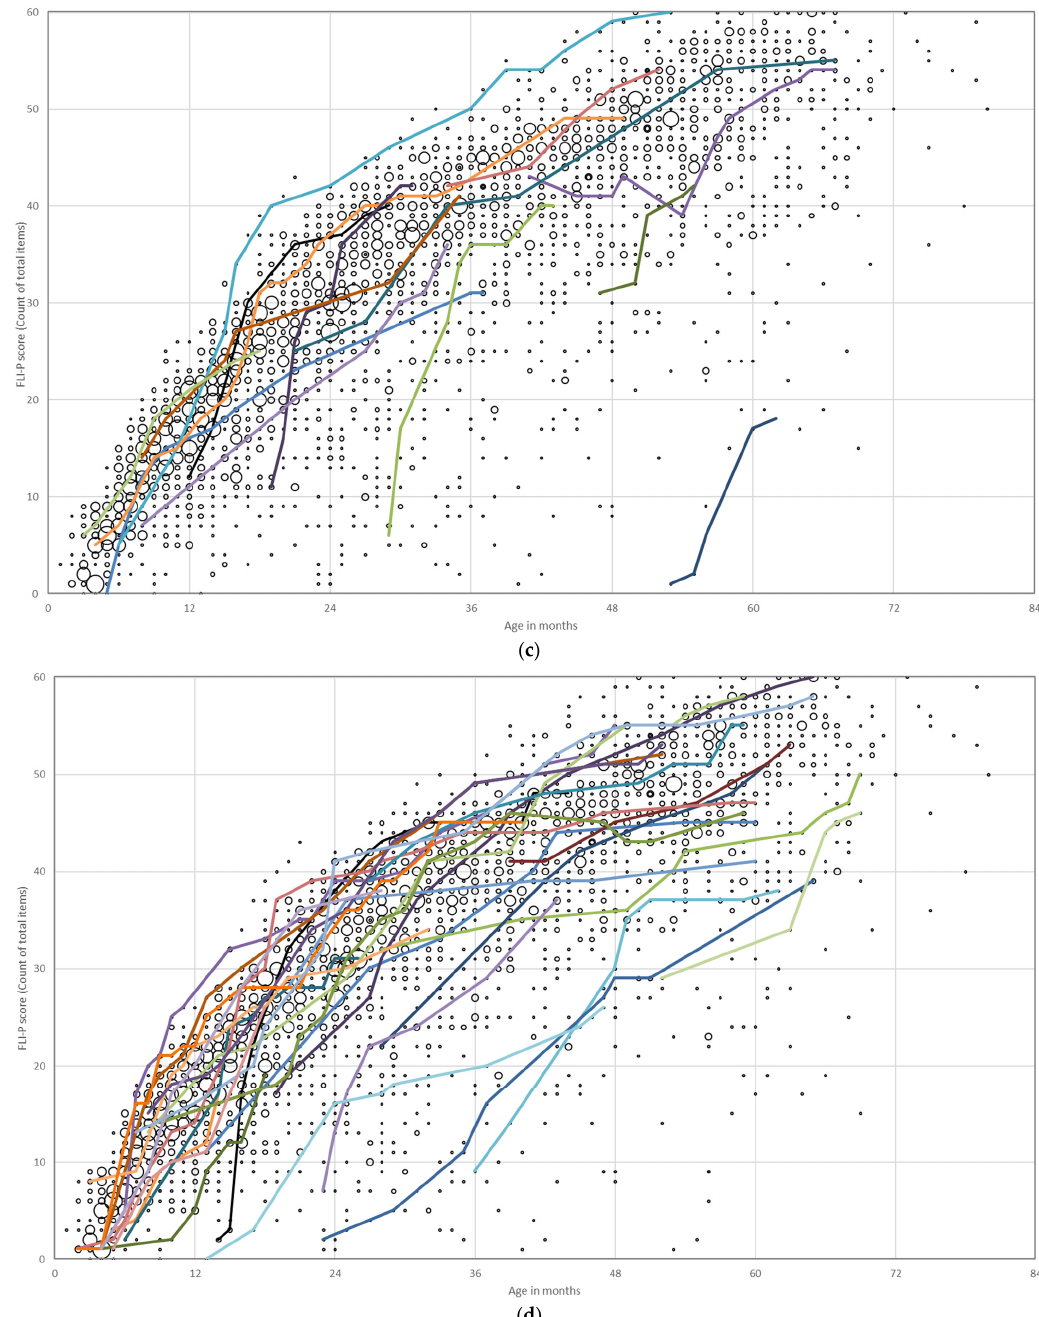
Figure 2. Individual listening trajectories of FLI-P scores of children with bilateral ( a ) mild, mild– moderate, and mild–profound (41 children); ( b ) moderate and moderate–severe (33 children); ( c ) se- vere and severe–profound (16 children); and ( d ) profound hearing loss (30 children). Each of the colored lines represents an individual child’s trajectory to highlight progress and different listening development